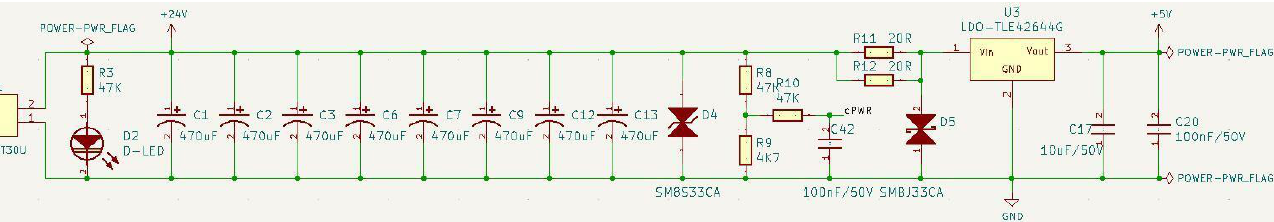
Figure 7. Schematic diagram of the servo driver power supply circuit.